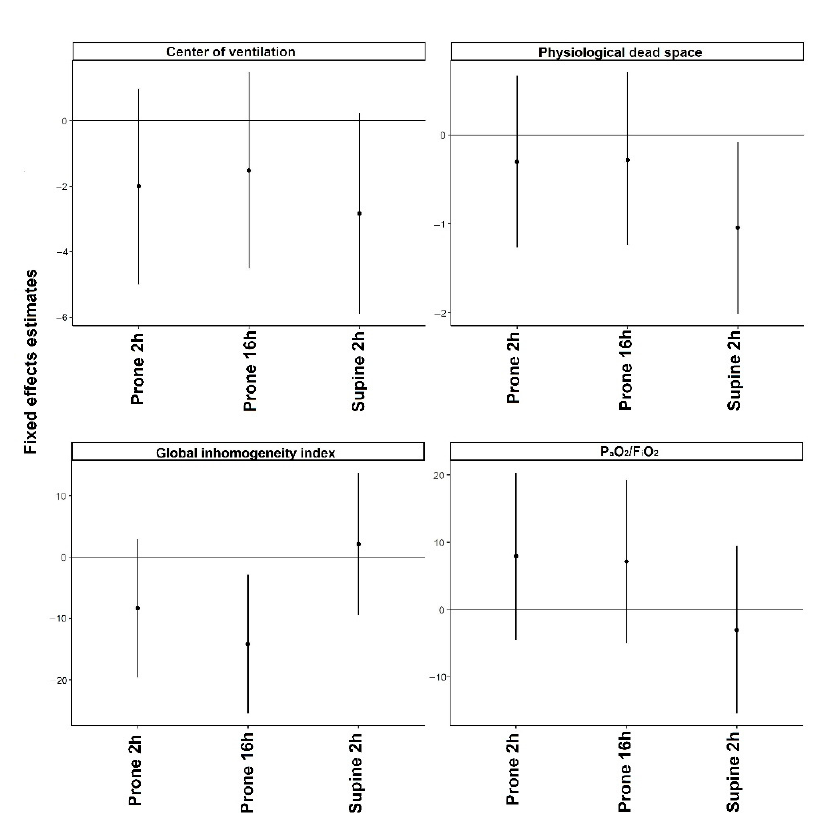
Figure 1. Mixed effect models with a random intercept and only fixed effects using as a fixed variable the examination time and dependent variables the global ventilatory parameters. Values before prone position (PP) were considered reference values. The regression coefficients and 95% confidence intervals indicate the probability of each variable to be higher or lower compared to the reference value at each time point.